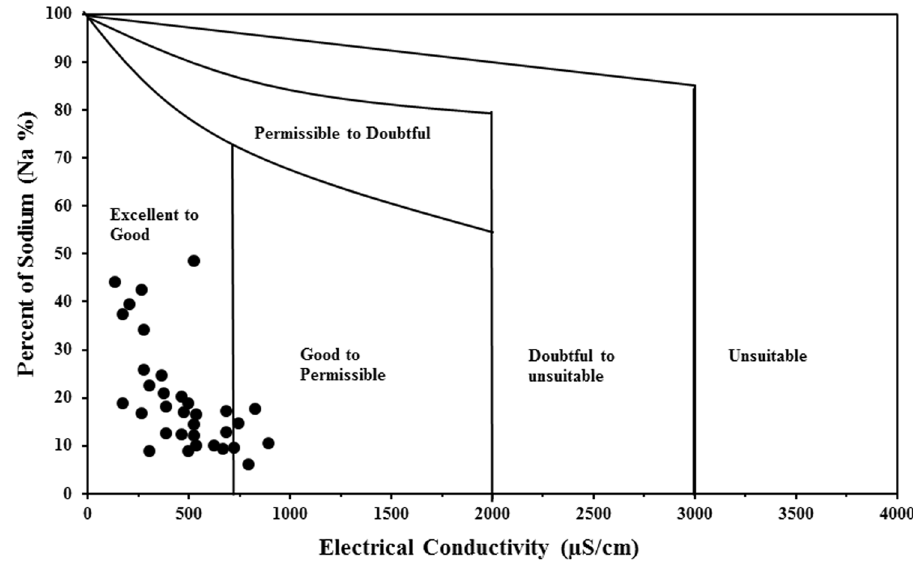
Fig. 7 Wilcox diagram dem- onstrating suitability of water quality for irrigational